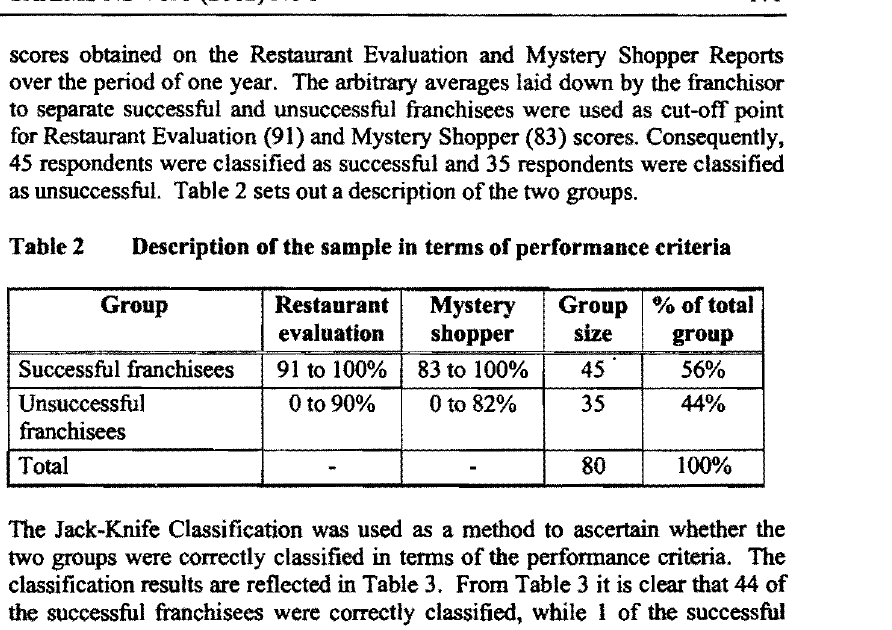
Predicted group membersbip in terms of performance